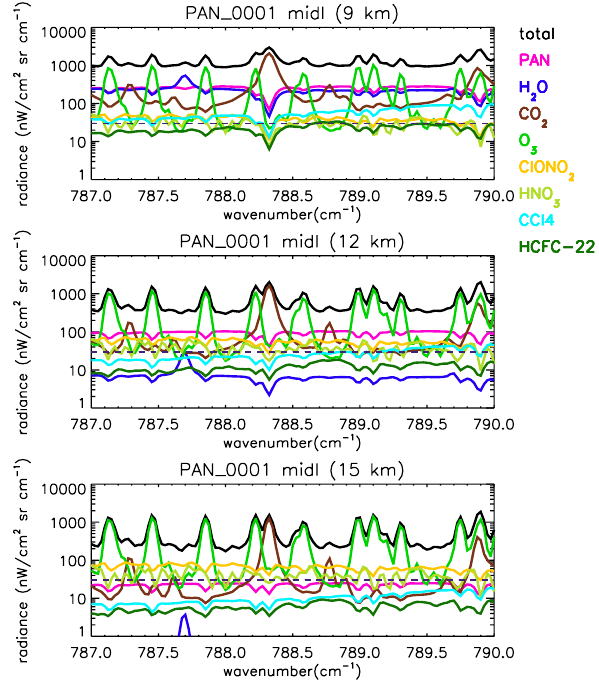
Fig. 1. Modelled radiance contributions in the 787 to 790 cm − 1 spectral range in mid-latitudes (20 to 65 degrees). A “typical” MIPAS-E in flight noise equivalent spectral radiance (NESR) of 30nW/(cm 2 srcm − 1 ) in band A, Kleinert et al. (2007), is repre- sented by the black dashed